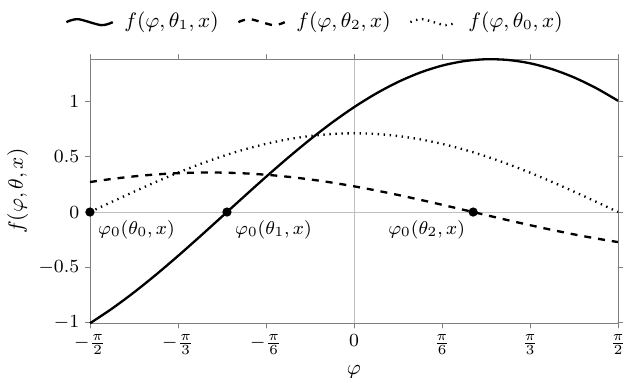
Figure 1. The graph of the function f ( ϕ , θ , x ) at x < 1 (the curve is plotted at x = 0.7) and different values of the parameter θ : θ 0 = ( 2/ π ) arcsin x , θ 1 < θ 0 , θ 2 > θ 0 . Heavy dots demonstrate the value of the solution of the Equation f ( ϕ , θ , x ) = 0 for values θ = θ 0 , θ 1 , θ 2 .